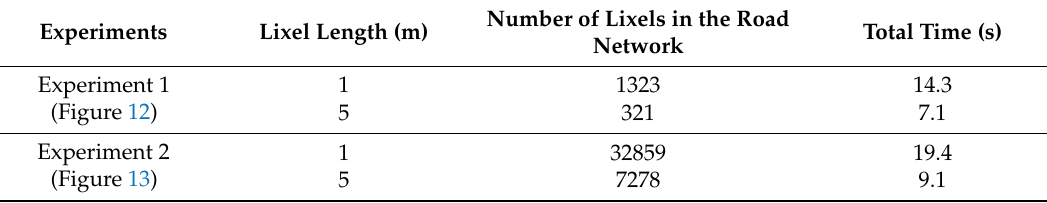
Table 3. Time costed in point